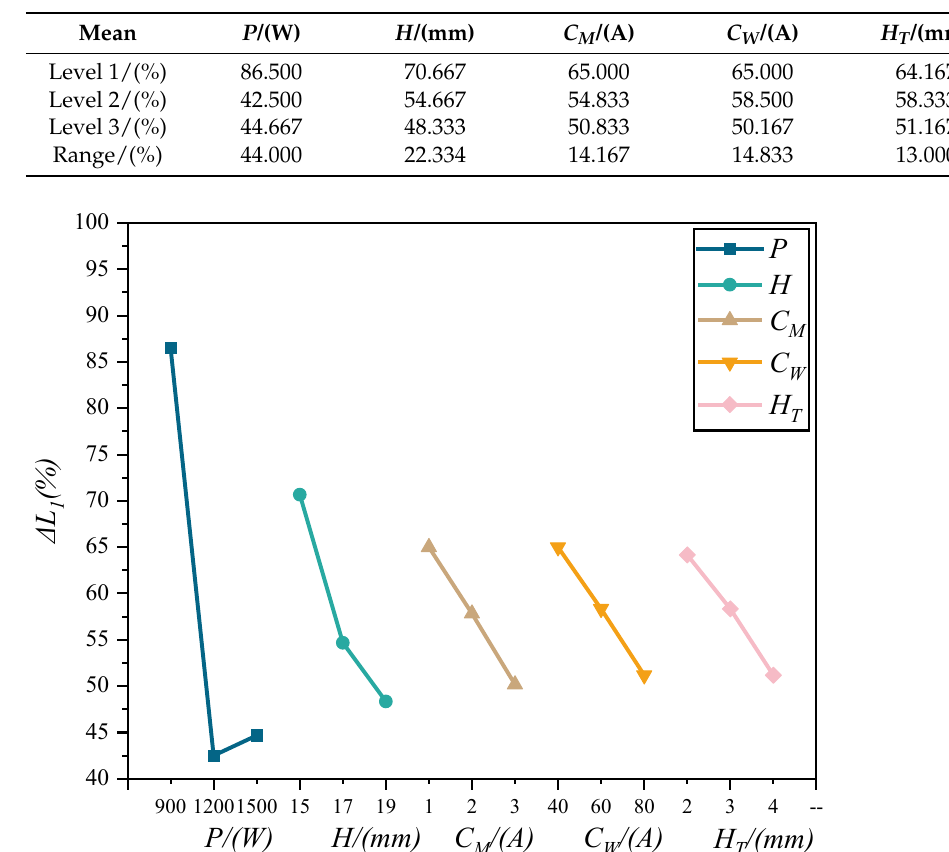
Figure 6. Trend diagram of Δ L 1 with the variation of process parameters.